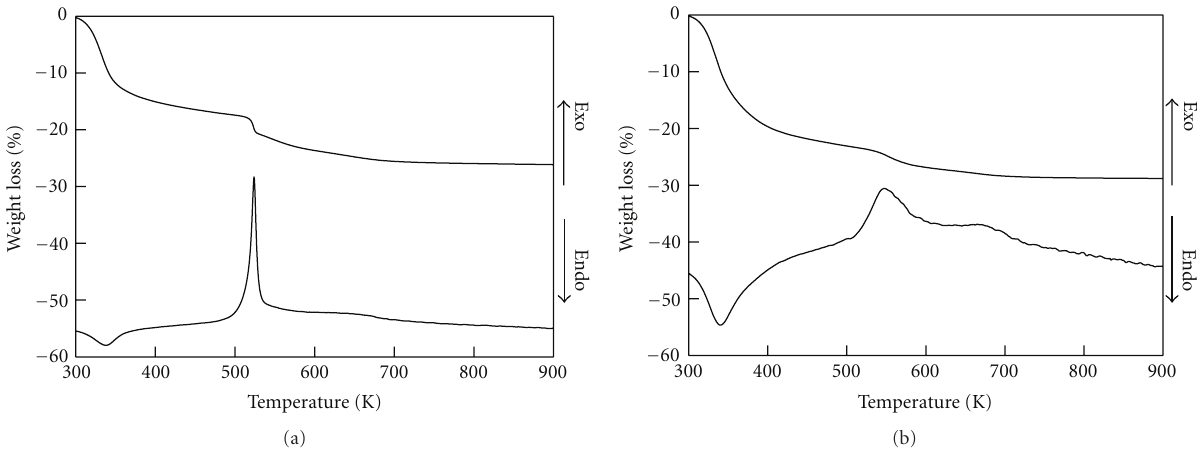
Figure 3: TG-DTA curves of the titanium oxide nanoparticles obtained by heating the mixture of ethylene glycol solution of TIP and NH 3 (aq). The [NH 3 ] values were (a) 0.1mol/L and (b)